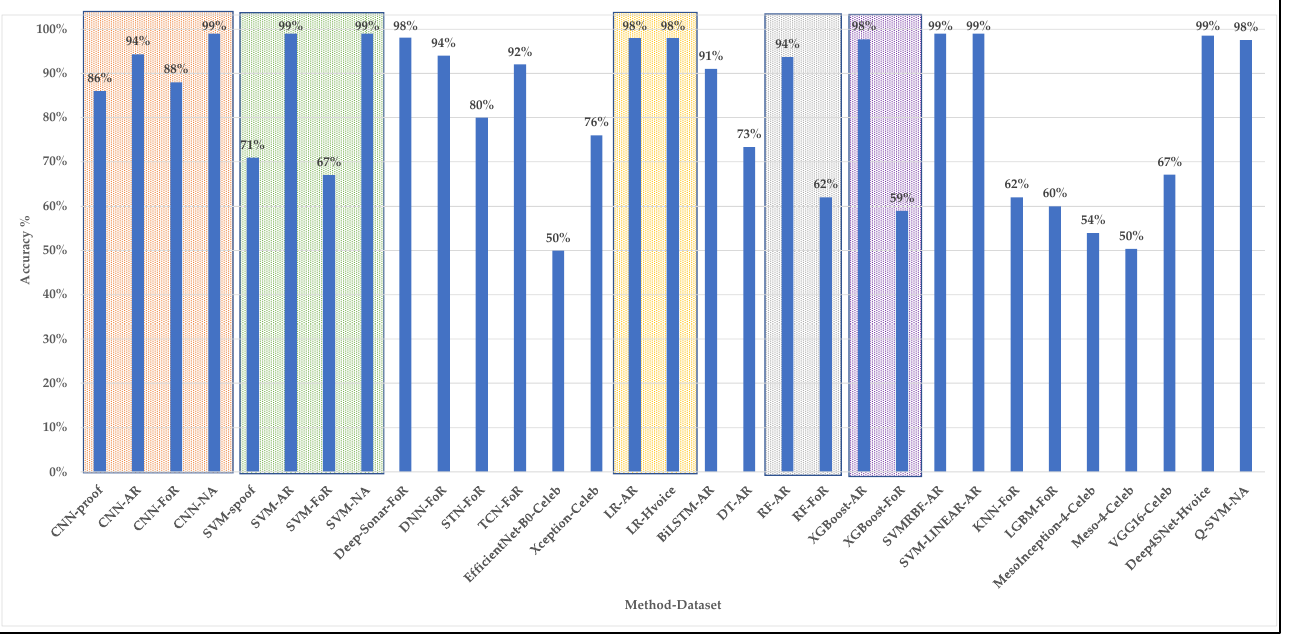
Figure 6. Quantitative comparison between recent AD detection methods measured by accuracy on multiple datasets.